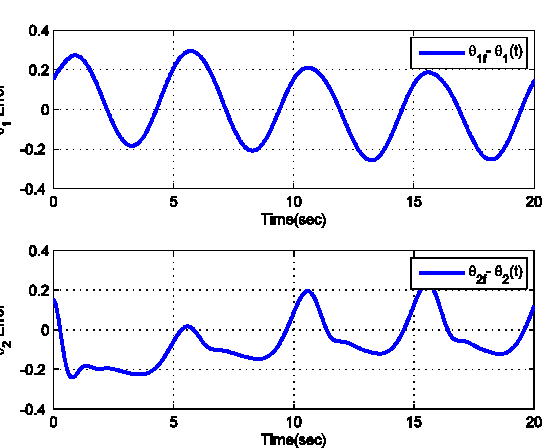
Fig. 15. RBECE joints trajectories.